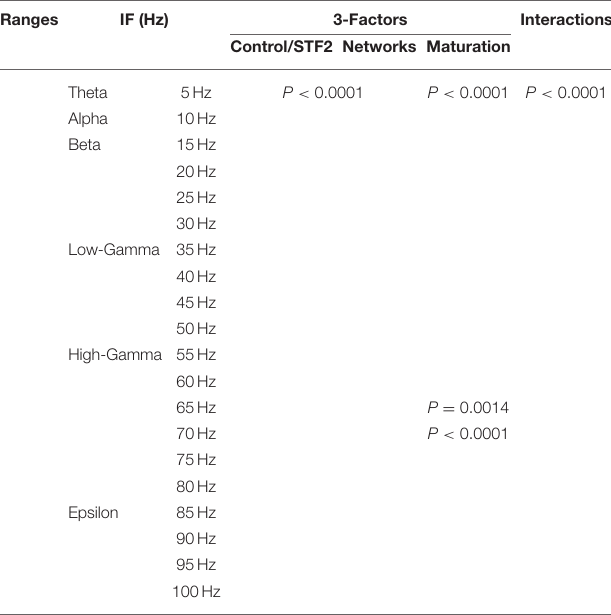
TABLE 4 | Three-way ANOVA for STF2.